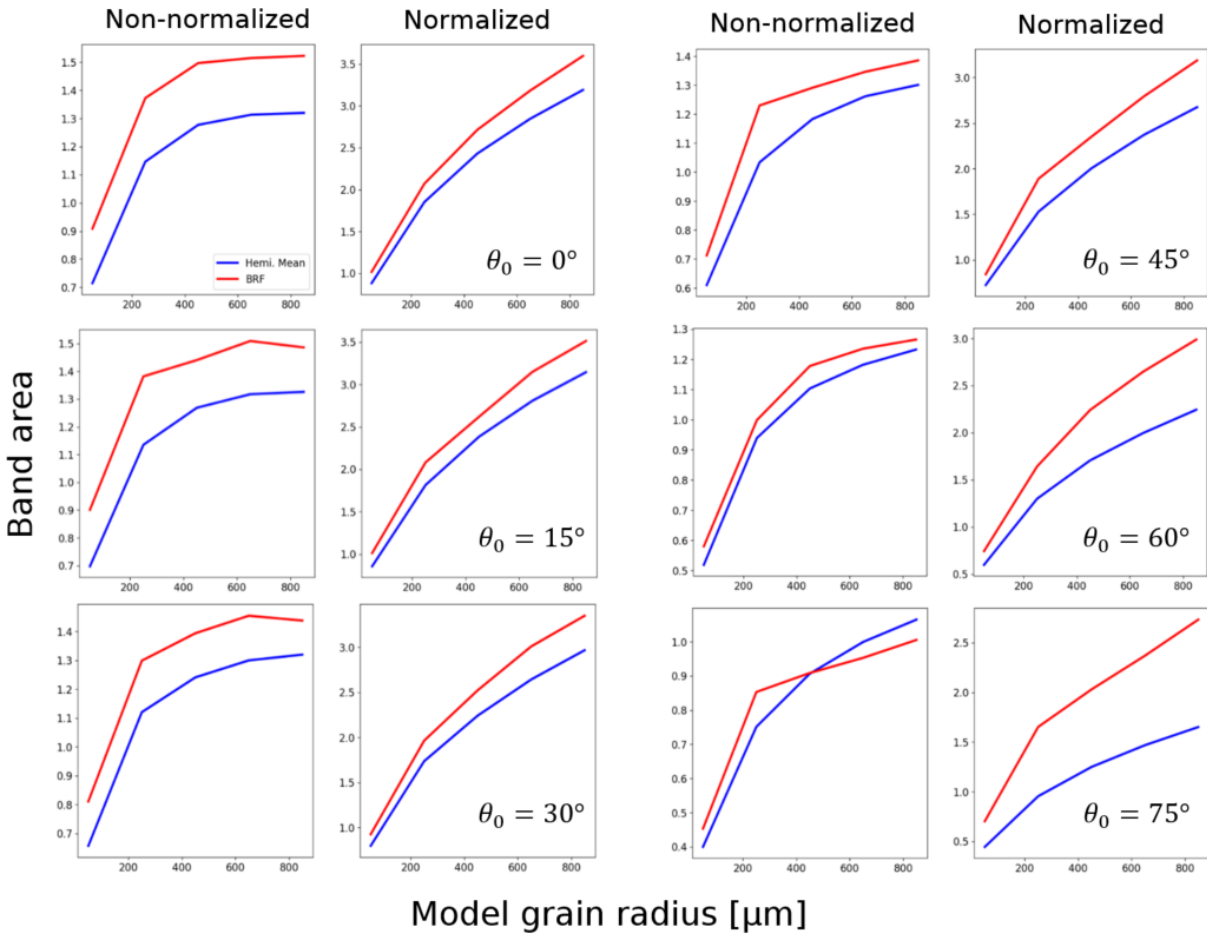
Figure 11. Calibration curves for band area vs. model grain radius, derived using the hemispheric reflectance (blue) and BRF (red) curves from Fig. 10. Columns 1 and 3 use band area without continuum scaling (Eq. 4), whereas columns 2 and 4 are calculated using Eq.